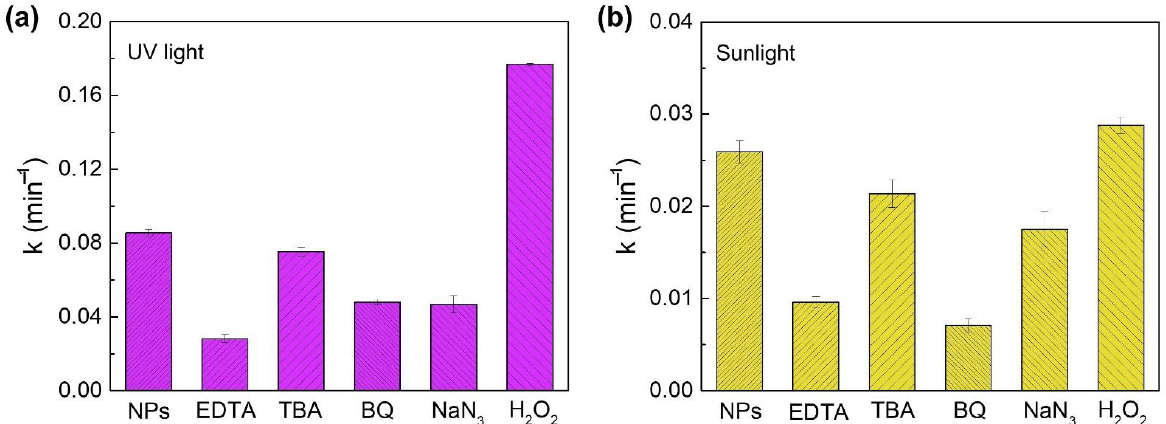
Figure 8. Comparison of the degradation rates of RhB under ( a ) UV light and ( b ) natural sunlight using Zn 2 SnO 4 nanoparticles (10 min) as photocatalyst in the presence of different scavengers (EDTA, TBA, BQ, NaN 3 , and H 2 O 2 ) and without adding any scavenger.